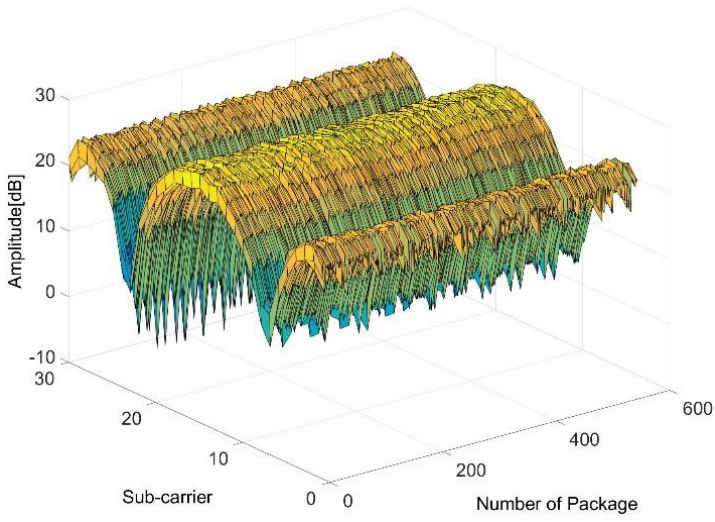
Figure 7. Raw WCI for normal breathing.